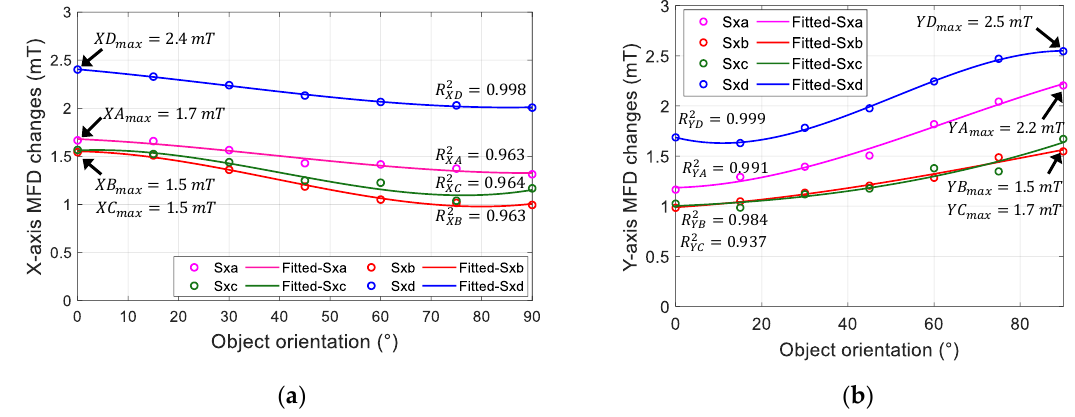
Figure 10. Changes in MFD of sensor output along ( a ) x-axis and ( b ) y-axis when the thin board was pushed on top of the surface with different orientations.